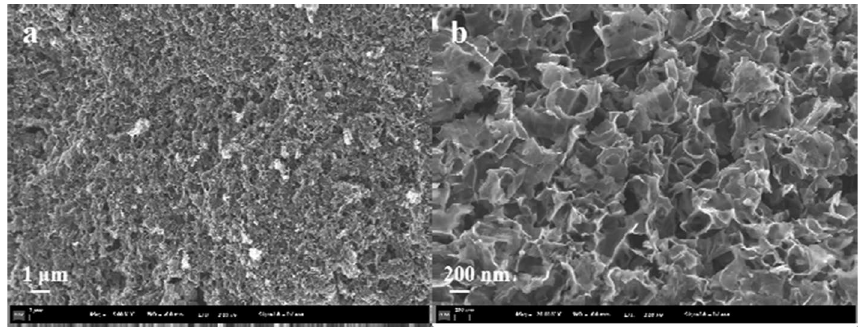
Fig. 1 The SEM results of 3D AFC for low magnification ( a ) and high magnification ( b